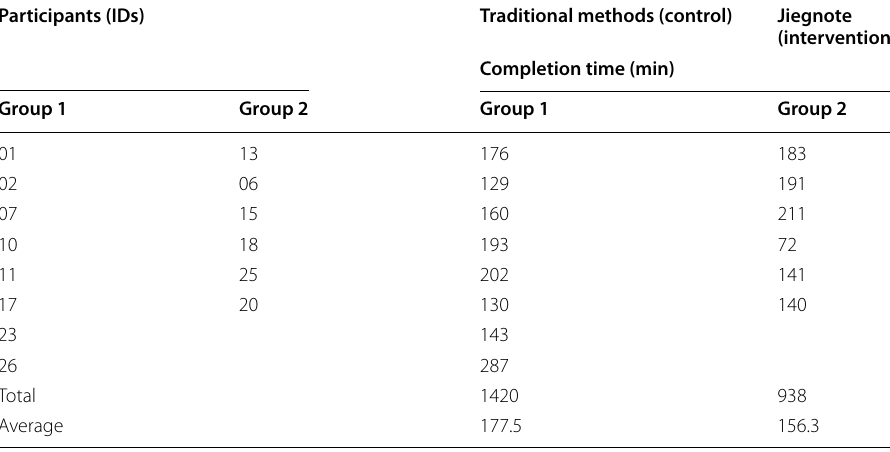
Table 1 The translation and transcription completion time for cases; A, and B Participants